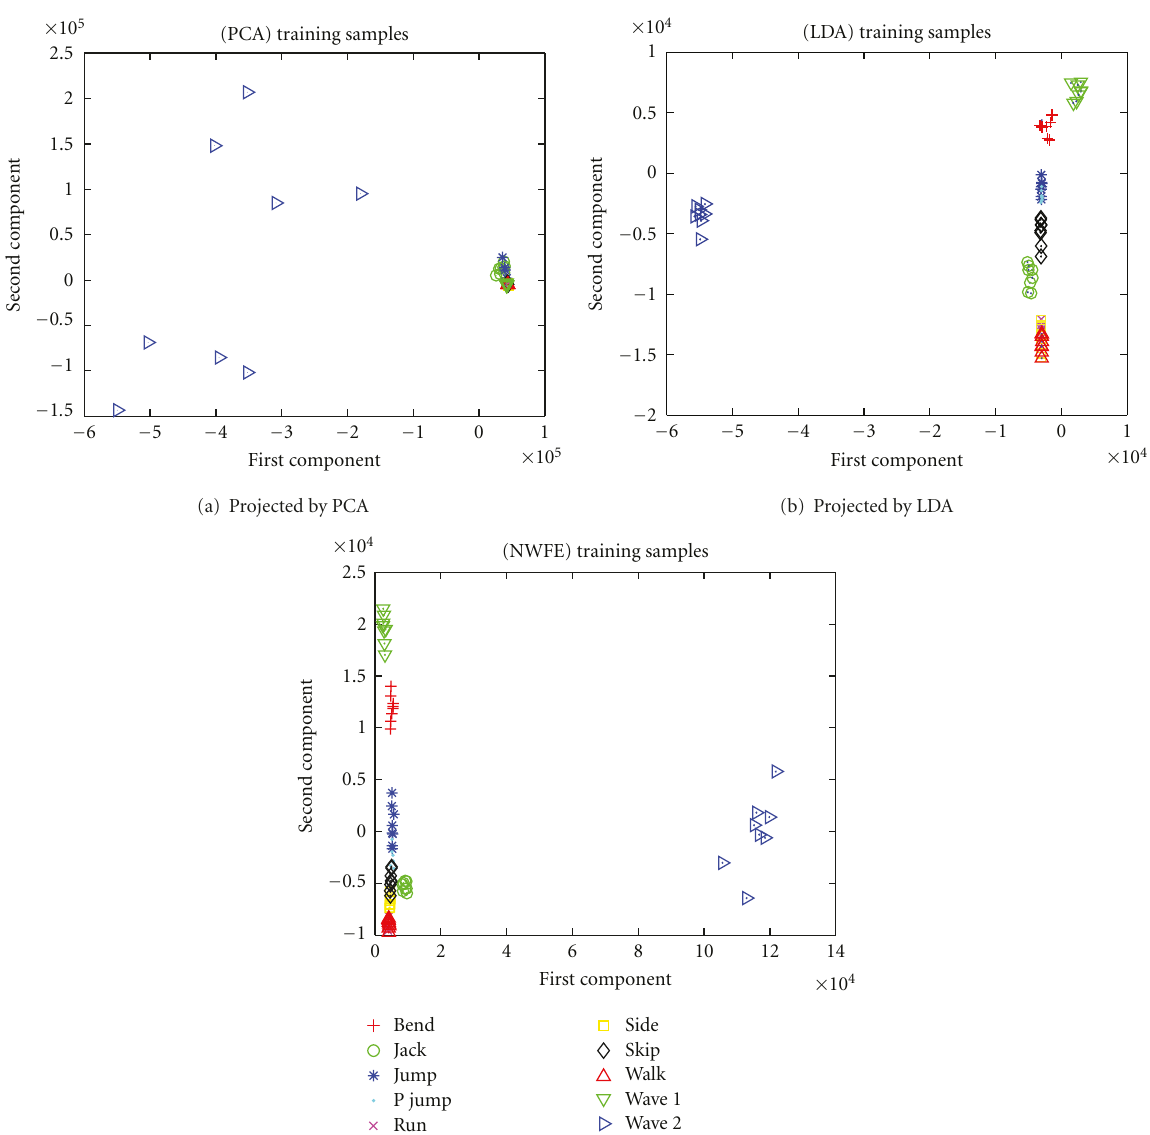
Figure 11: Training samples are projected onto a two-dimensional subspace by di ff erent